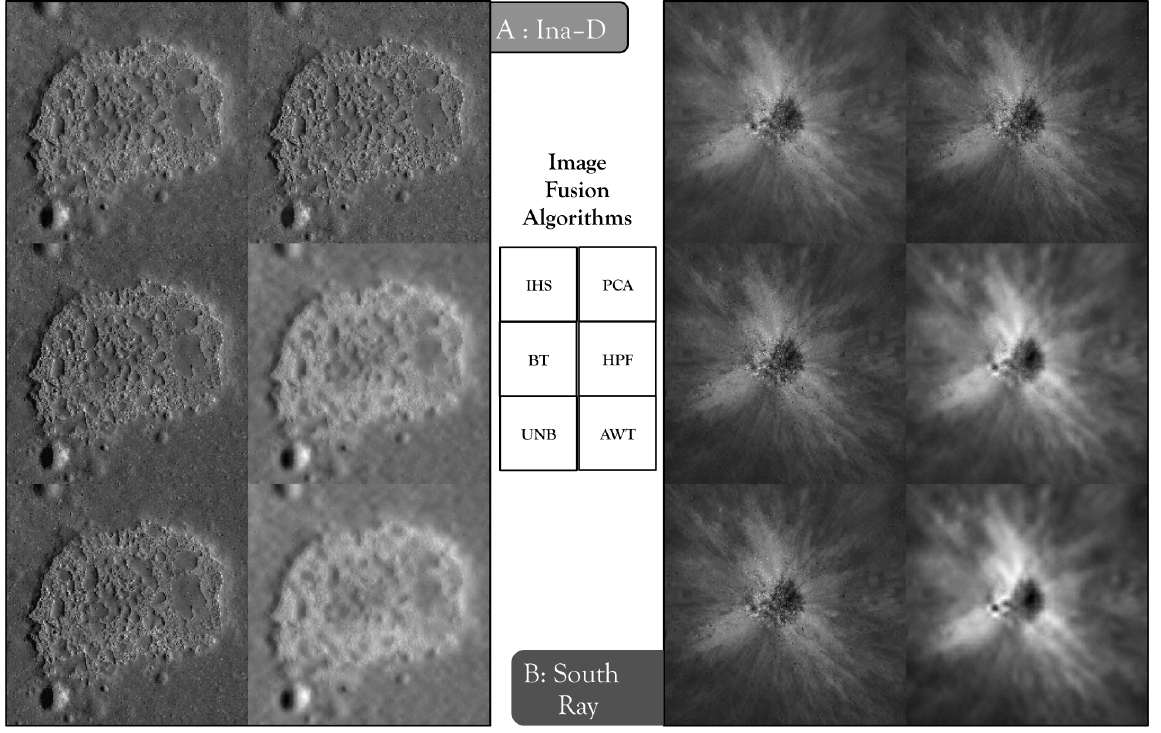
Figure 4: Image fusion results for LROC WAC Vis 5 band